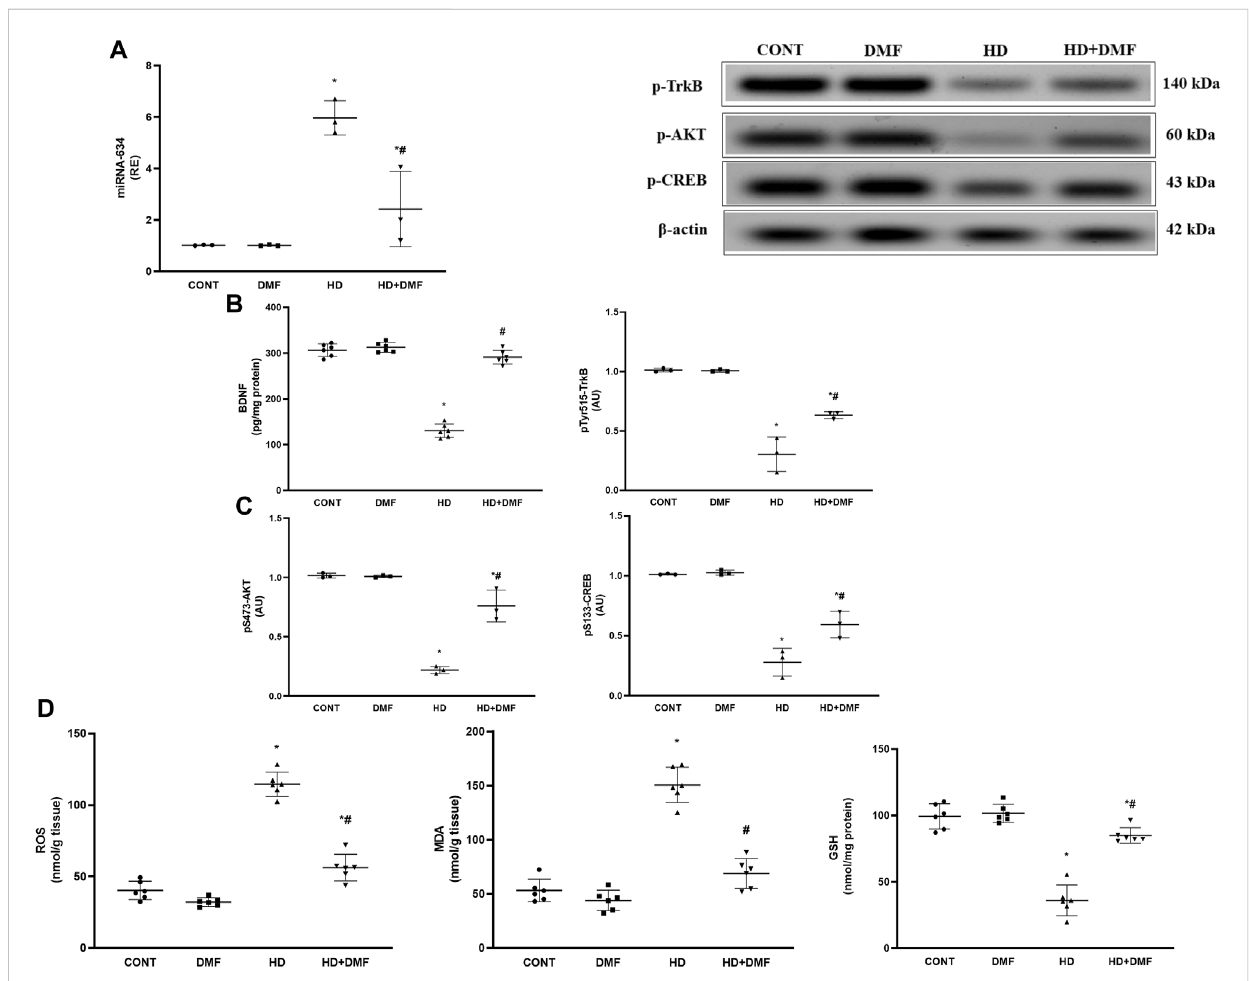
FIGURE 6 Effect of DMF on striatal (A) miRNA-634 expression; content/protein expression of (B) BDNF and p-TrkB; protein expression of (C) p-AKT and p-CREB; and content of (D) MDA, ROS, and GSH in the striatum of HD rats. Data are represented as mean ± SD ( n = 3 rats/group for PCR,WB; n = 6 rats/ groupforELISA)usingone-wayANOVA,followedbyTukey ’ s posthoc test*vs.CONTand#vs.HDat p < 0.05.AKT,proteinkinaseB;BDNF,brain-derived neurotrophic factor; CONT, control; CREB, cAMP response element-binding protein; DMF, dimethyl fumarate; GSH, glutathione; HD, Huntington ’ s disease; MDA, malondialdehyde, miRNA-634, microRNA-634; ROS, reactive oxygen species; TrkB, tropomyosin receptor kinase